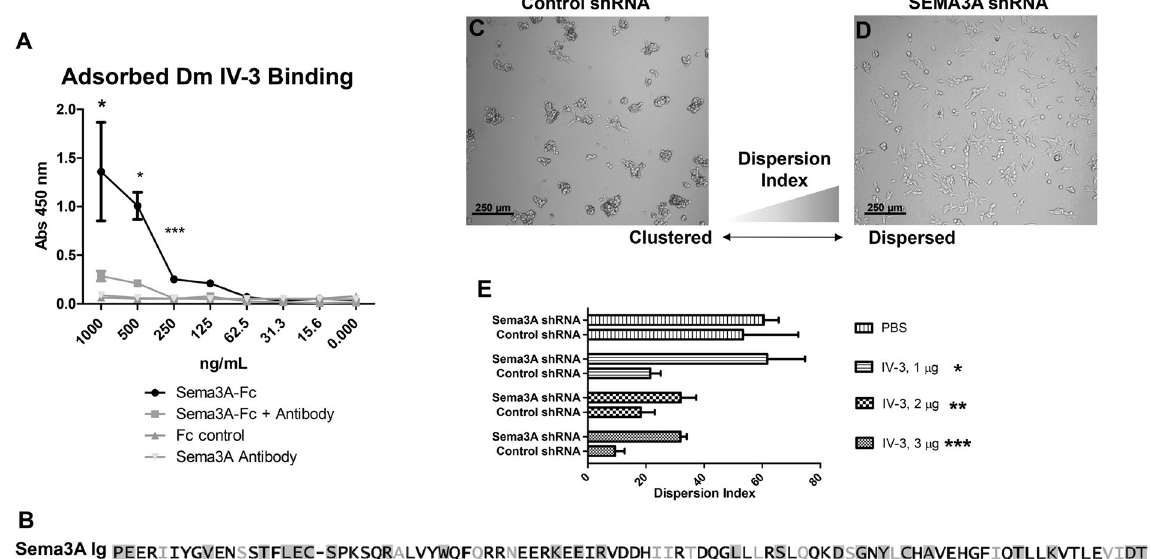
Figure 6. Sema3A binds Domain IV-3 and shRNA against Sema3A abrogates C4-2 cell clustering. ( A ) Domain IV-3 was adsorbed to well surfaces and subjected to a binding assay with Sema3A-Fc, Sema3A-Fc and Sema3A antibody, Sema3A antibody alone, and control IgG. Sema3A-Fc binds to Domain IV-3 and Sema3A antibody diminishes the binding signal significantly to 250 ng/mL (student’s unpaired t-test per concentration). ( B ) Blossom62 alignment of Ig 17 of perlecan (2 nd of Domain IV-3) and the Ig of Sema3A. C4-2 cells were seeded on Domain IV-3 after being transduced with either control shRNA (panel C) or Sema3A directed shRNA (panel D). ( E ) Dispersion index quantification between control and directed shRNA for each substrate type and amount. Significance values are student’s unpaired t-test between control and Sema3A shRNA. p-values: * < 0.05, ** < 0.01, *** < 0.001.